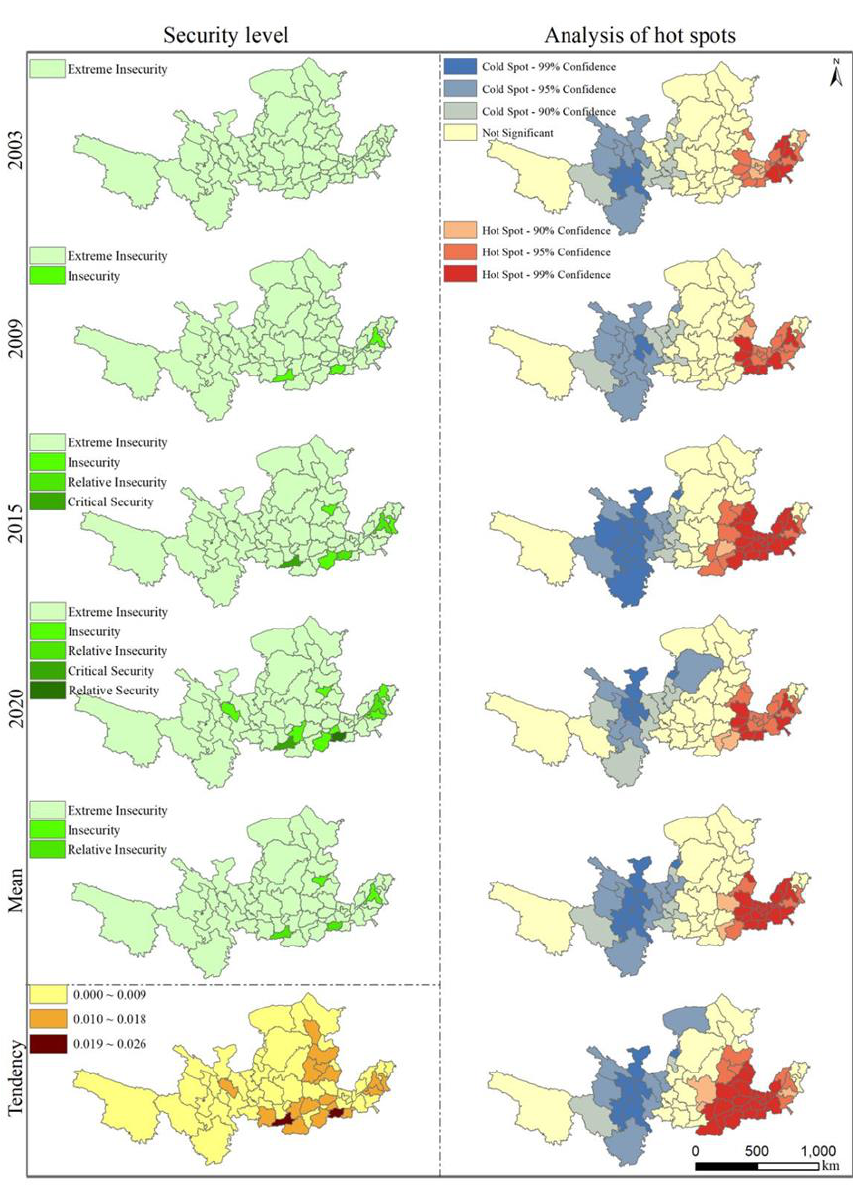
Figure 5. Spatial evolution and hotspot analysis of the tourism eco-security index of the Yellow River basin. River